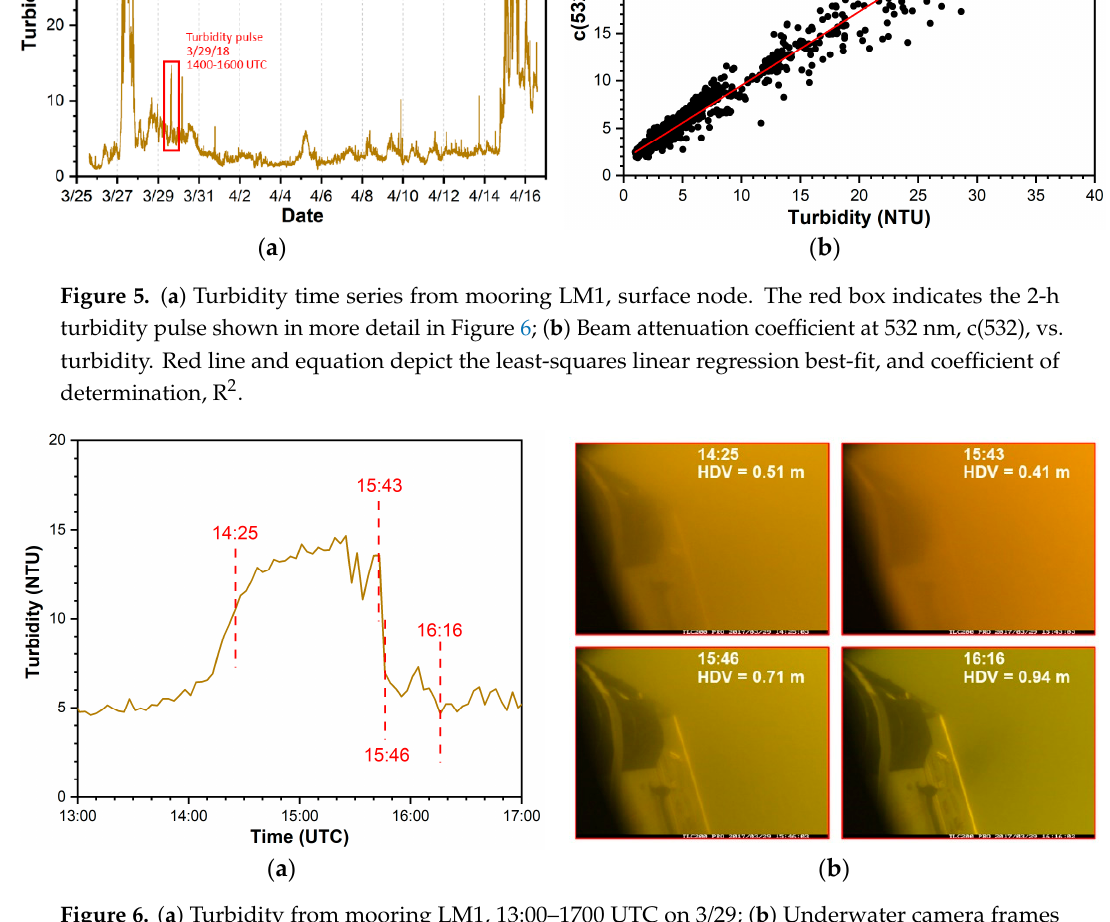
Figure 6. ( a ) Turbidity from mooring LM1, 13:00–1700 UTC on 3/29; ( b ) Underwater camera frames corresponding to times indicated in a . Horizontal diver visibility calculated from c(532) is indicated on each frame.